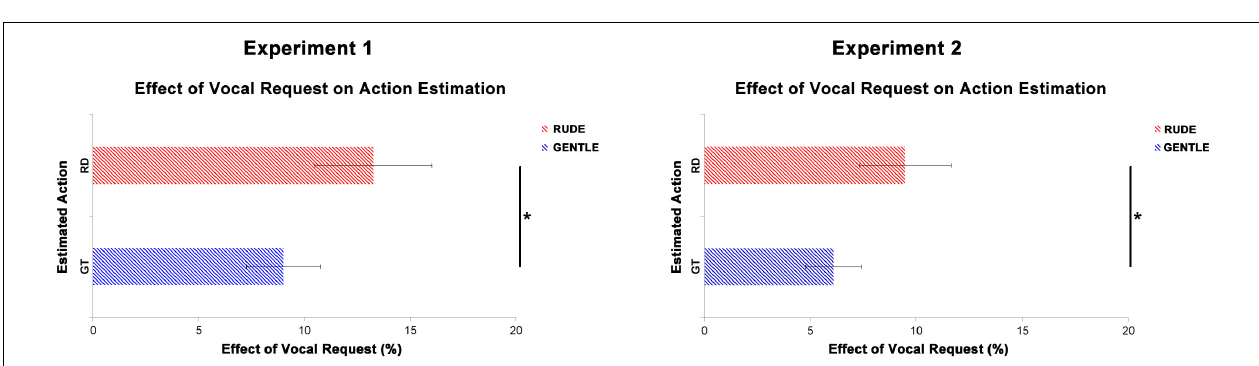
FIGURE 5 | At the top, graphs show results obtained from the analysis of gentle (A) and rude (B) actions estimation. Green bars refer to incongruent conditions: rude vocal request and gentle action (RDV_GTA) in panel (A) , gentle vocal request and rude action (GTV_RDA) in panel (B) . Blue bars in panel (A) refer to gentle congruent condition: gentle vocal request and gentle action (GTV_GTA). Red bars in panel (B) refer to rude congruent condition: rude vocal request and rude action (RDV_RDA). At the bottom, graphs show the effect of rude vocal requests on gentle action estimation (C) and the effect of gentle vocal requests on rude action estimation (D) for five different time delays (0, 400, 800, 1,200, and 1,600 ms). ** p < 0.01, and *** p < 0.001.